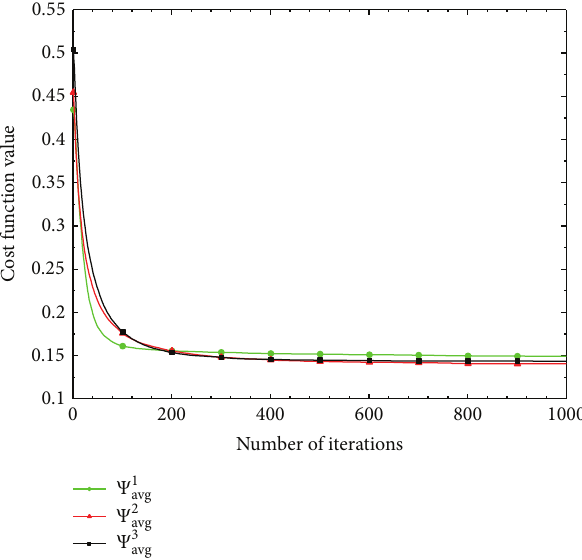
Figure 15: The average convergence behaviour of the three methods for SC— Ψ 𝑘 represents the cost function value and 𝑘 represents the method used, where 𝑘 = 1 : SBL, 𝑘 = 2 : SR, and 𝑘 = 3 : SB.